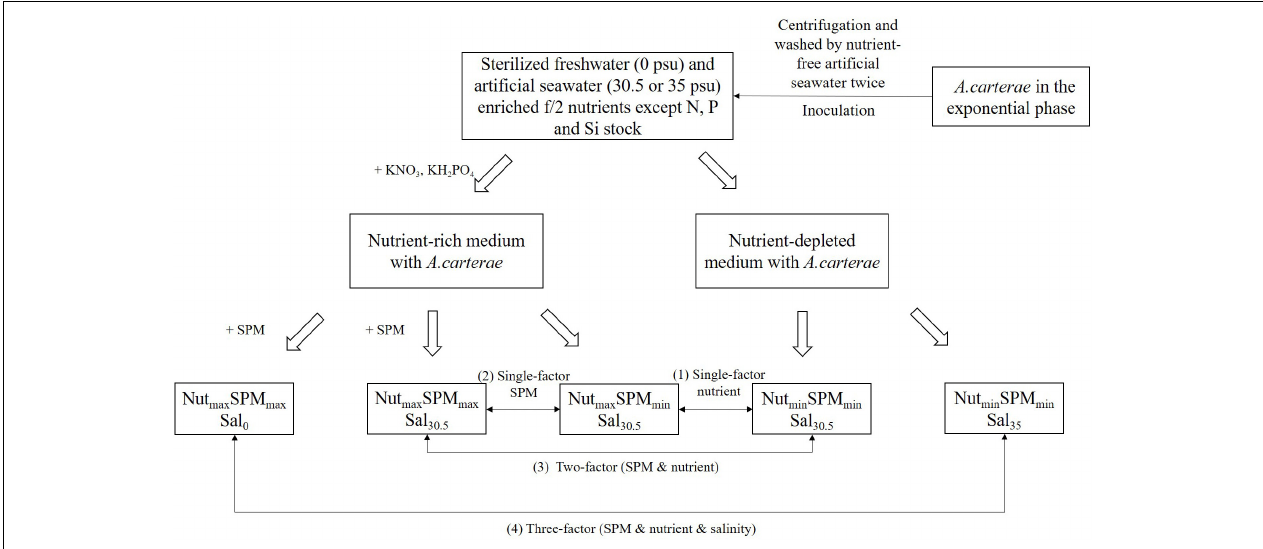
FIGURE 1 | The design of the four groups of incubation experiment: (1) single-factor nutrient experiment, (2) single-factor SPM experiment, (3) two-factor (SPM and nutrient) experiment, (4) three-factor (SPM, nutrient, and salinity) experiment. The double-headed arrow lines represent the mixing between two stock solutions which generated eight different levels of nutrient, SPM, and/or salinity individually or in combination ( Table 1 ). The maximum concentrations of nutrient (Nut max : DIN = 98.8 µ M, DIP = 2.9 µ M) and SPM (SPM max = 2.5 g/L) was set be close to the properties of river end member observed in natural eutrophic estuaries. The minimum concentrations of nutrient (Nut min : DIN = 0 µ M, DIP = 0.3 µ M) and SPM (SPM min = 0 g/L) were similar with the properties of oceanic end member. The subscripts for “Sal” represent the salinities of different stock solutions.